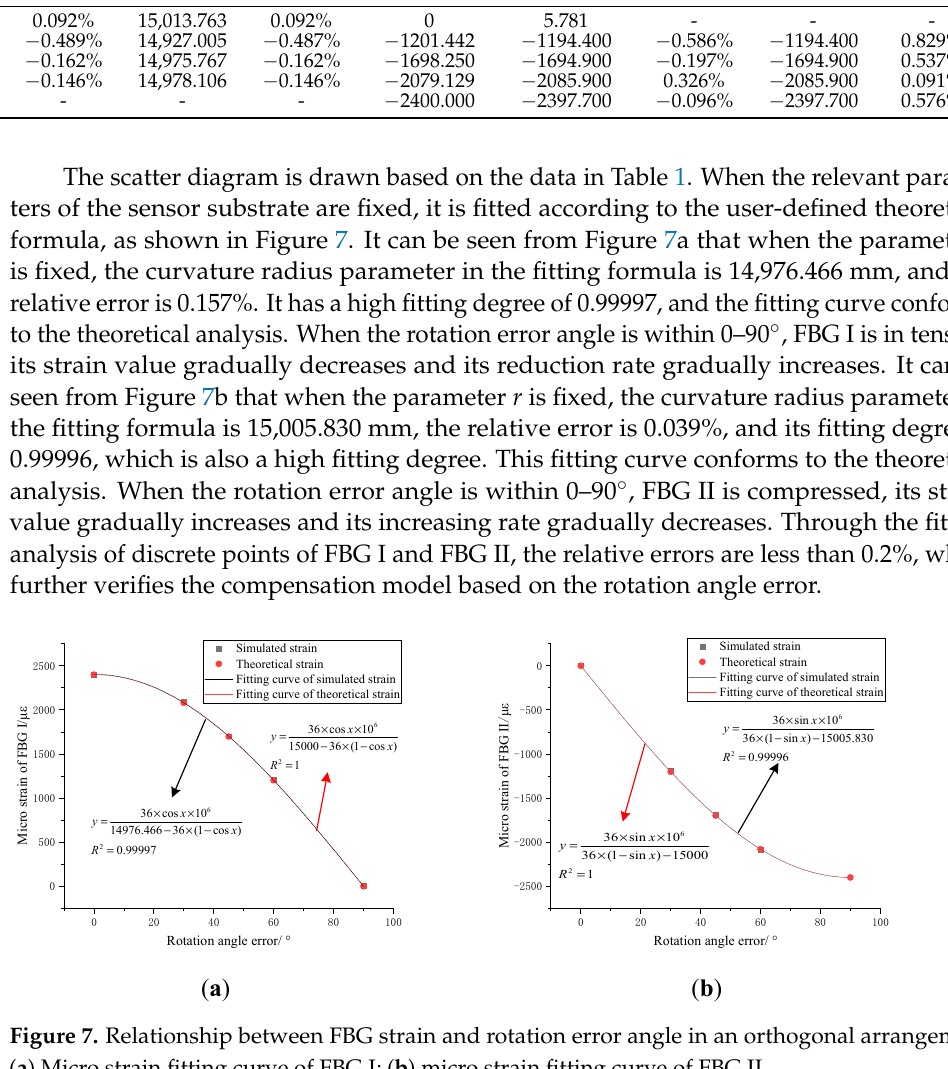
( b ) Figure 8. Curvature rotation error angle test system of FBG curvature sensor of scraper conveyor. ( a ) Experimental schematic diagram; ( b ) photo of experiment process. HKA-M FBG demodulator is mainly used for data acquisition. The demodulator is integrated with the computer and equipped with data demodulation software. Its wave- length range is 1525 ~ 1565 nm and wavelength resolution is 1 pm. The grating used in the sensor is directly written into the single-mode fiber in the core by ultraviolet laser. The length of the grid area is 10mm, and the initial center wavelength of the FBG curvature sensor of the scraper conveyor after packaging is shown in Table 2. Table 2. Initial center wavelength and curvature sensitivity coefficient of FBG curvature sensor of scraper conveyor after packaging. Grating Number